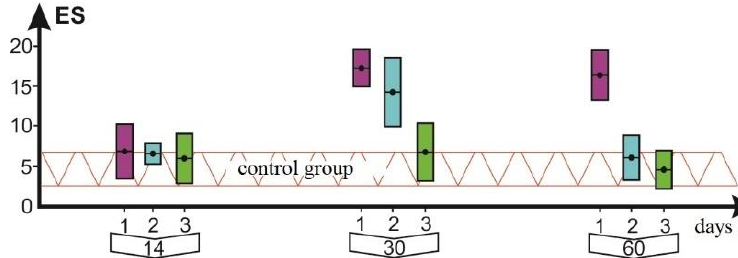
Figure 8. Eroded surface dynamics (ES).